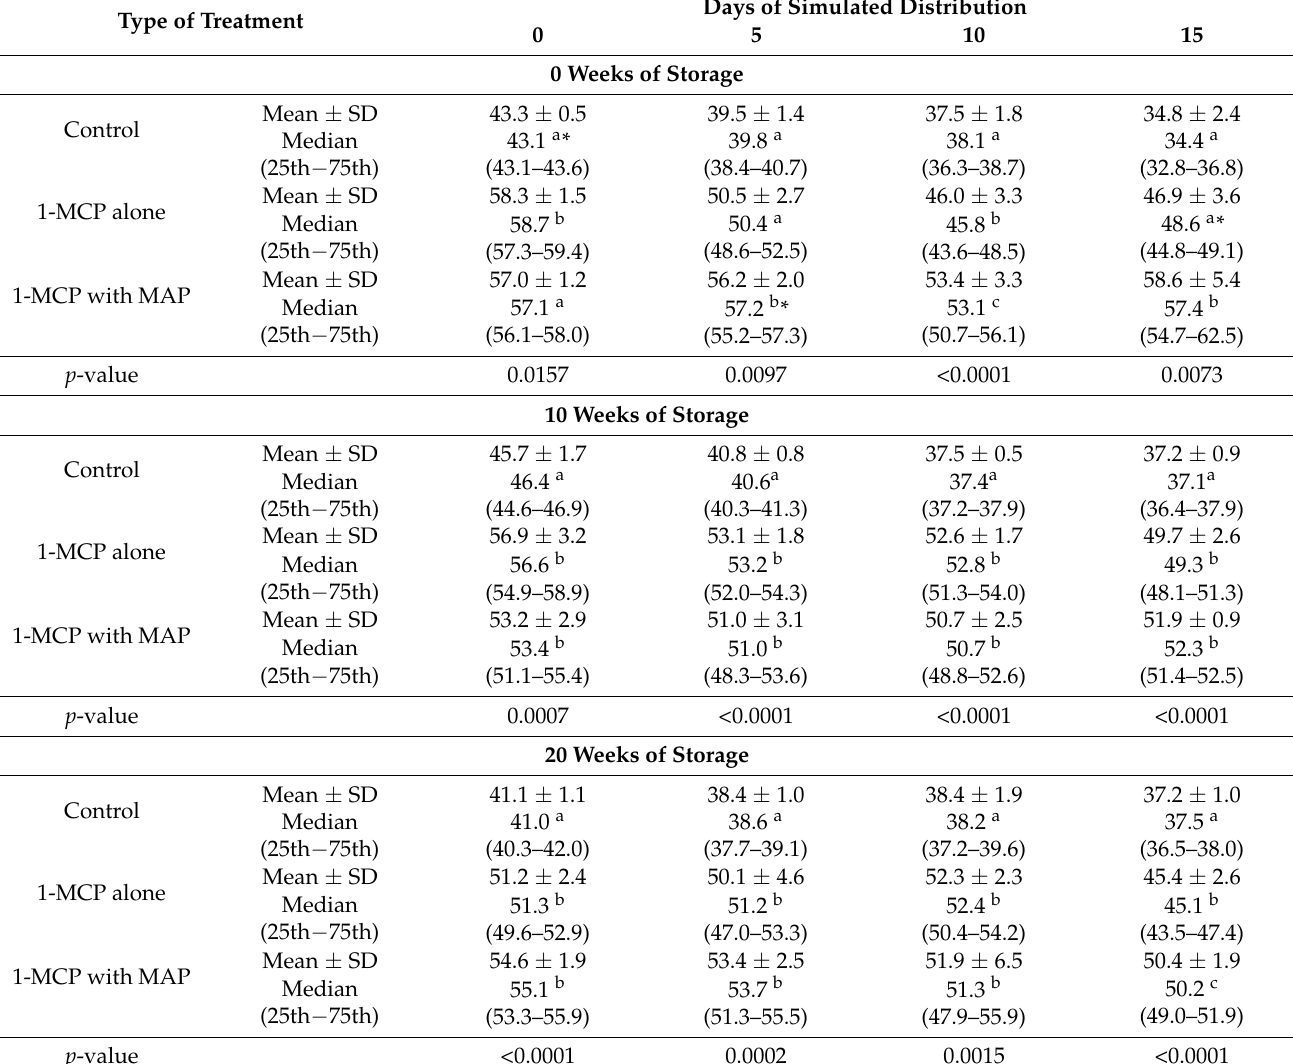
Table 2. The observed values of firmness (N) for Idared apples after 8 weeks of simulated transportation, for the sub-groups subjected to various postharvest treatments, storage duration and duration of